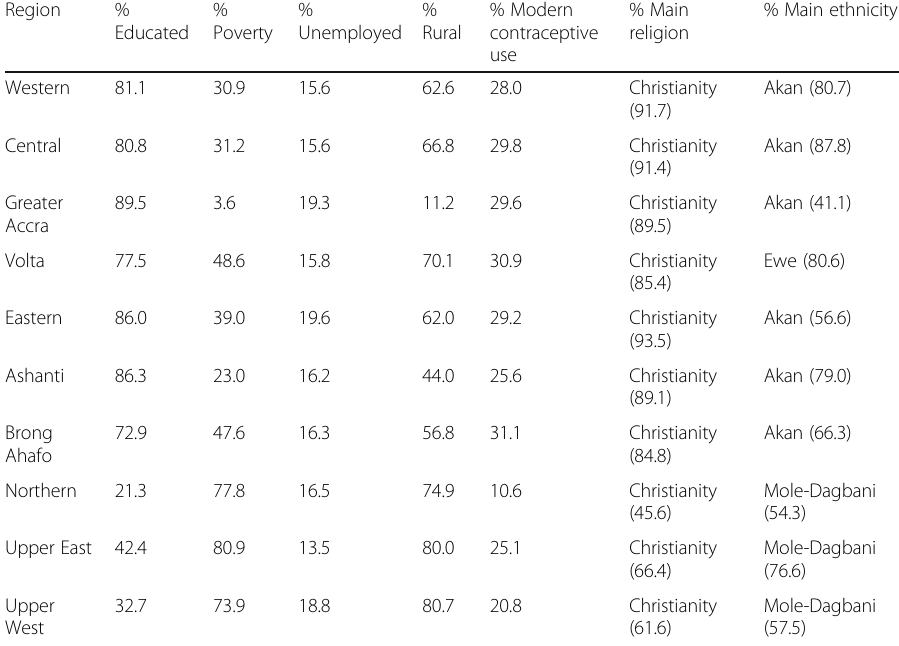
Table 2: Selected socioeconomic characteristics of the regions Region %